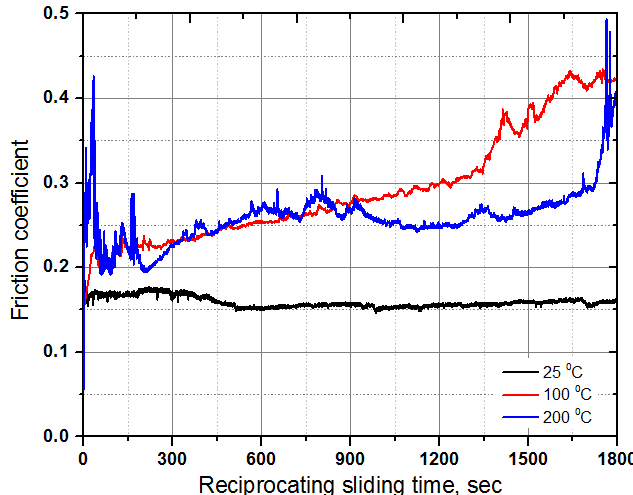
Figure 5. Variation in friction coefficient of the C/C-SiC composite with respect to time at temperatures of 25, 100 and 200 °C. Materials 2017 , 10 , 701